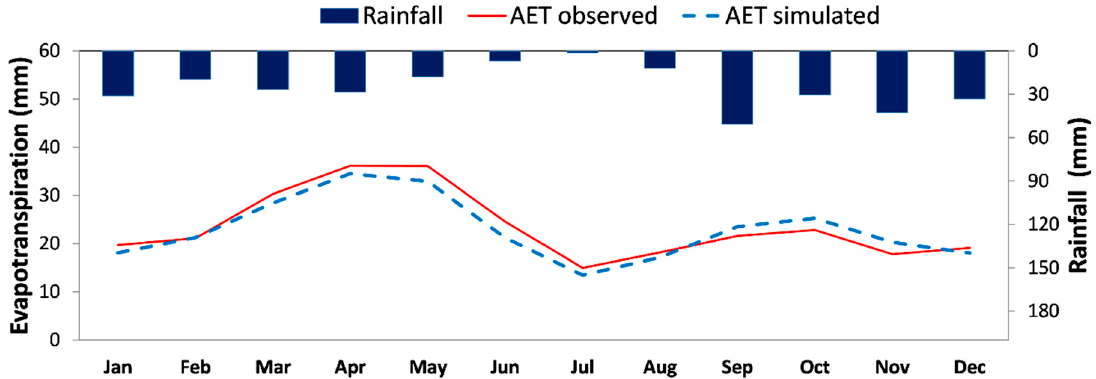
Figure 3. Comparison of average monthly simulated and observed AET for the calibration and validation periods.